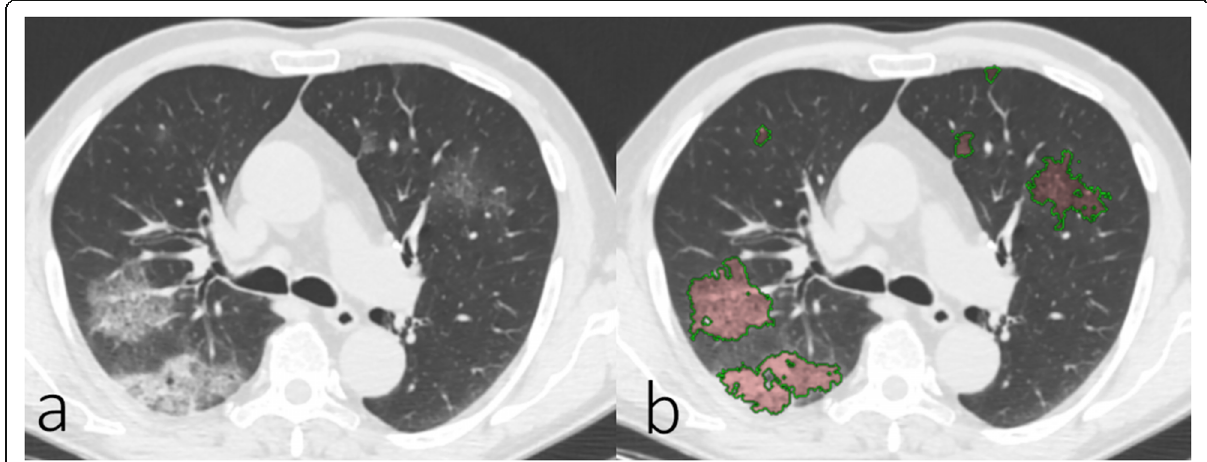
Fig. 3 Example of severe acute respiratory syndrome coronavirus 2 (SARS-CoV-2) lung disease segmentation. Typical SARS-CoV-2 pneumonia with lung opacities before ( a ) and after ( b ) semiautomatic